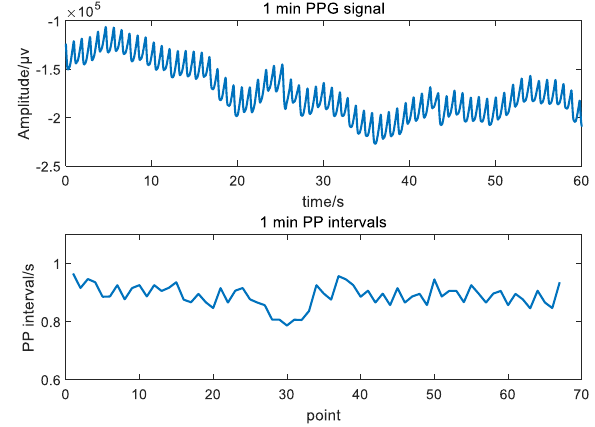
Figure 4. One minute PPG signal and its corresponding PP intervals.